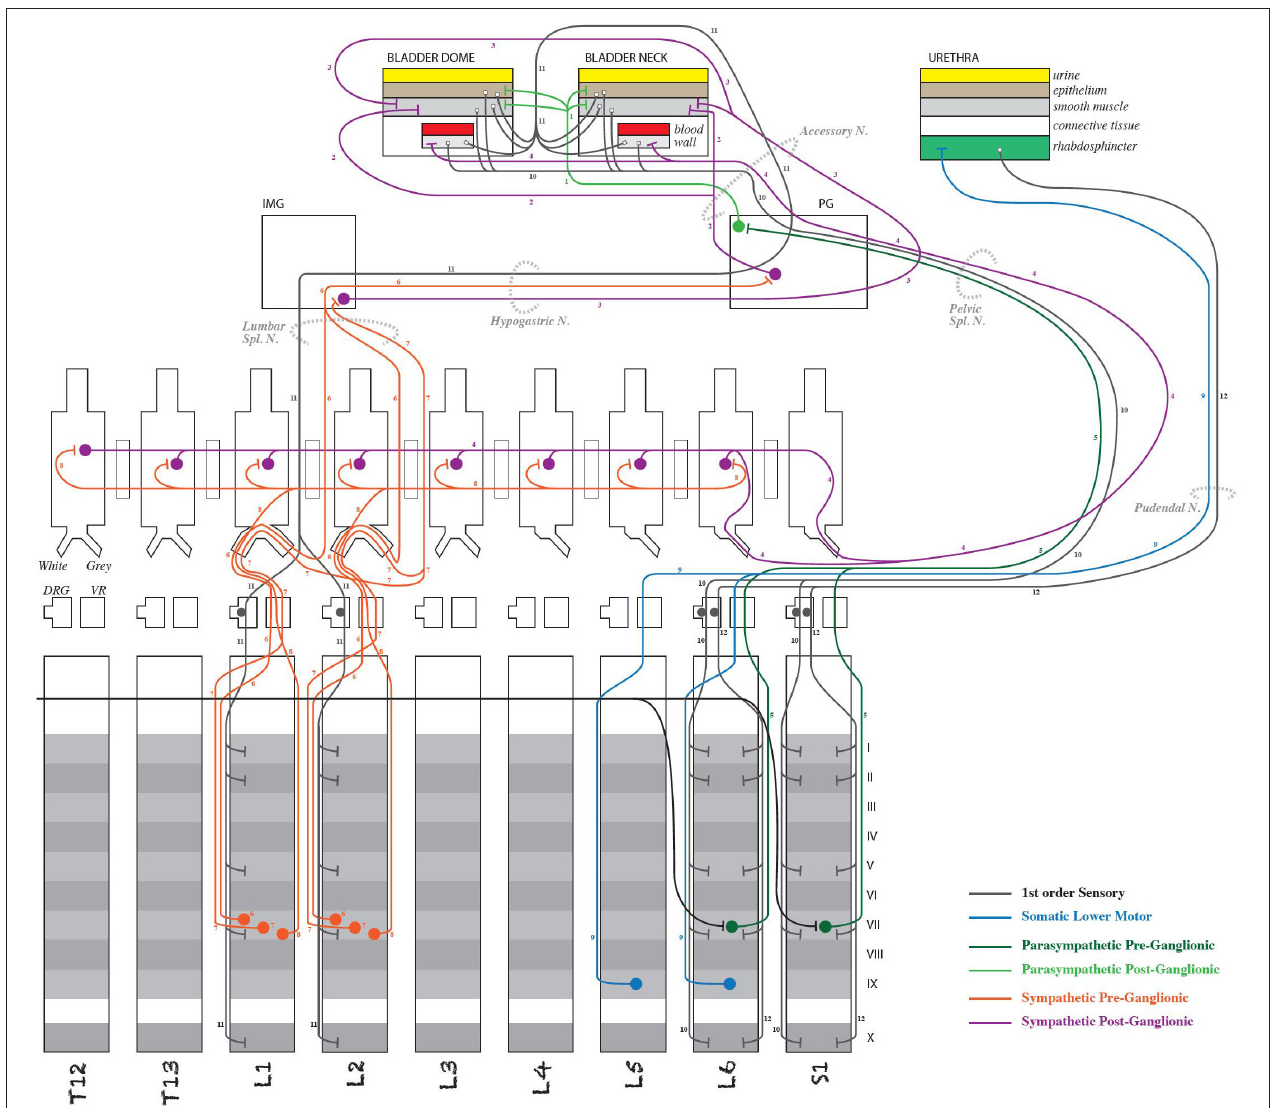
FIGURE 3 | Detail of an ApiNATOMY schematic diagram representing neural connectivity between the rodent spinal cord and the lower urinary tract (Surles-Zeigler et al., 2020). Note that the pathway information in diagrams such as this is stored in SPARC Connectivity Knowledge Base and used to render the pathways in the more anatomically oriented flatmaps (see Figure 4